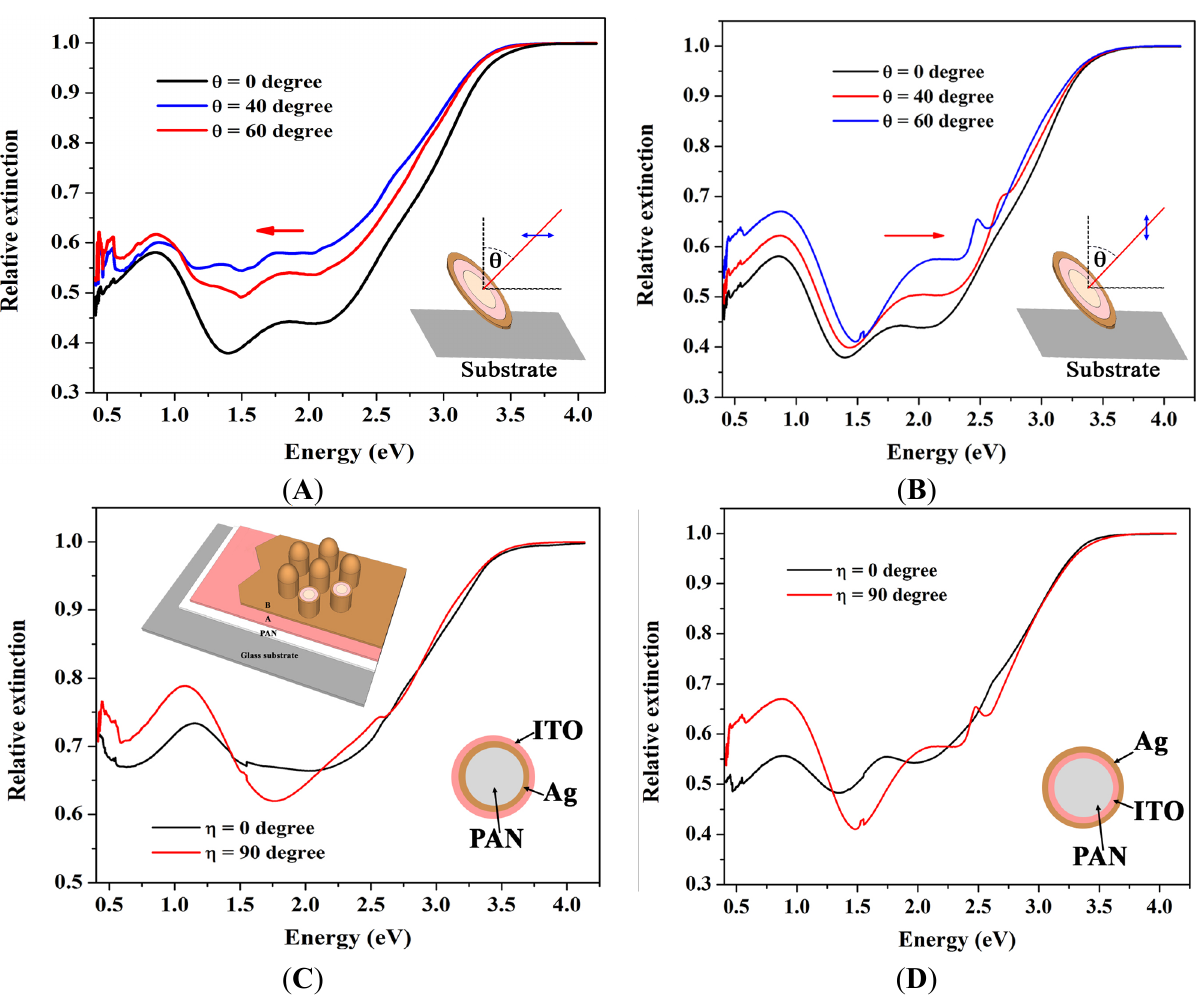
Figure 6. Relative extinction of ITO/Ag multilayered pillars at different angles of incidence for incident polarizations ( A ) parallel to the substrate ( B ) perpendicular to substrate and of ( C ) Ag/ITO and ( D ) ITO/Ag multilayered nanopillars at different polarizations of incident light for 60  angle of incidence. Bonding and antibonding hybridized plasmons are more separated at transverse (90  ) polarization. Inset in A and B are schematic descriptions of incident angles and polarizations with respect to the pillars and substrate